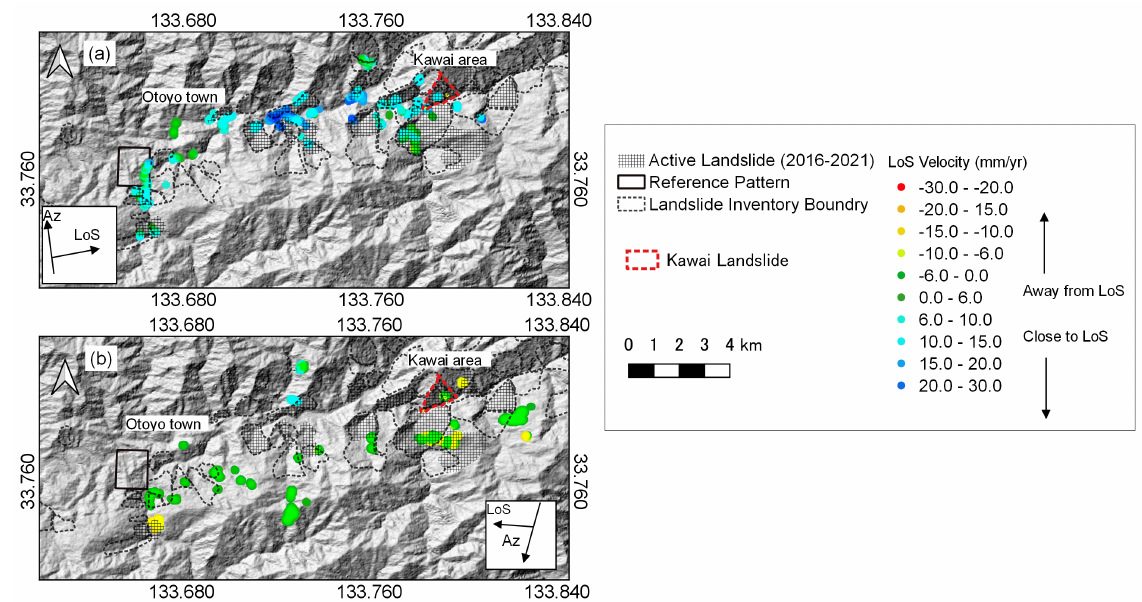
Figure 5. Sentinel-1 LoS velocity maps in Otoyo Town. The results of the LoS velocity analysis of the S-1 ascending track: ( a ) Blue regions indicate movement toward the LoS. The LoS velocity analysis results for the S-1 descending track: ( b ) Red regions represent movement away from the LoS. All LoS points are referenced against a stable, unvegetated, and low-relief pattern annotated with a black rectangle. The hashed regions represent active landslides, which were assessed by using inclinometer measurements from 2016 to